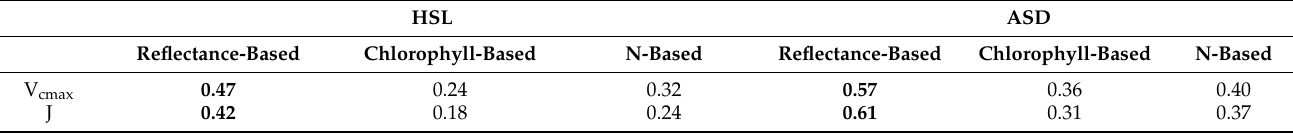
Table 2. The R 2 values of V cmax and J estimation results for HSL and ASD datasets. The highest R 2 values are shown in